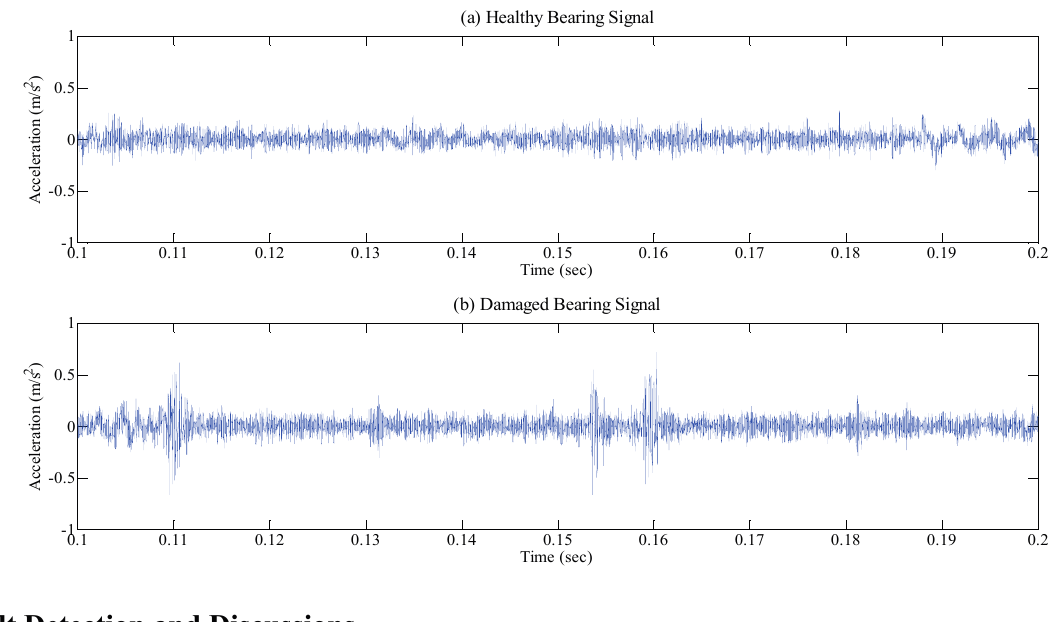
Figure 5. Measured bearing signals: ( a ) healthy condition; and ( b ) damaged